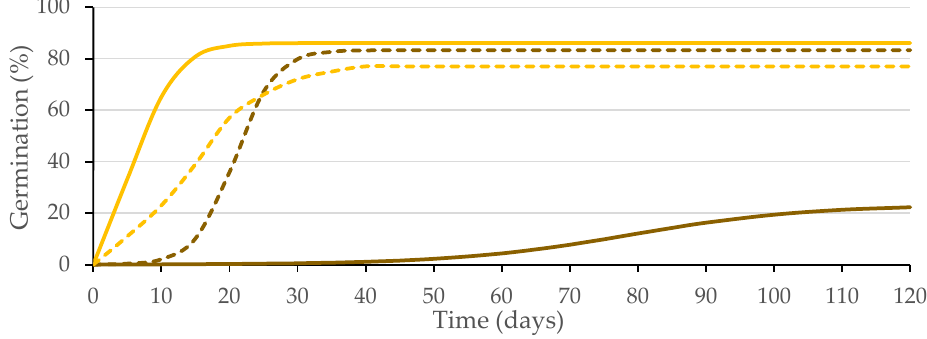
Table 1. Effect of the presence of the testa and the solution used to wet the substrate on the final germination ( A , %), the number of days needed to reach 50% of the final germination ( Gt 5 0 , d) and the relative average rate of accumulated germination ( k /2, d − 1 ). Average values of four replicates.